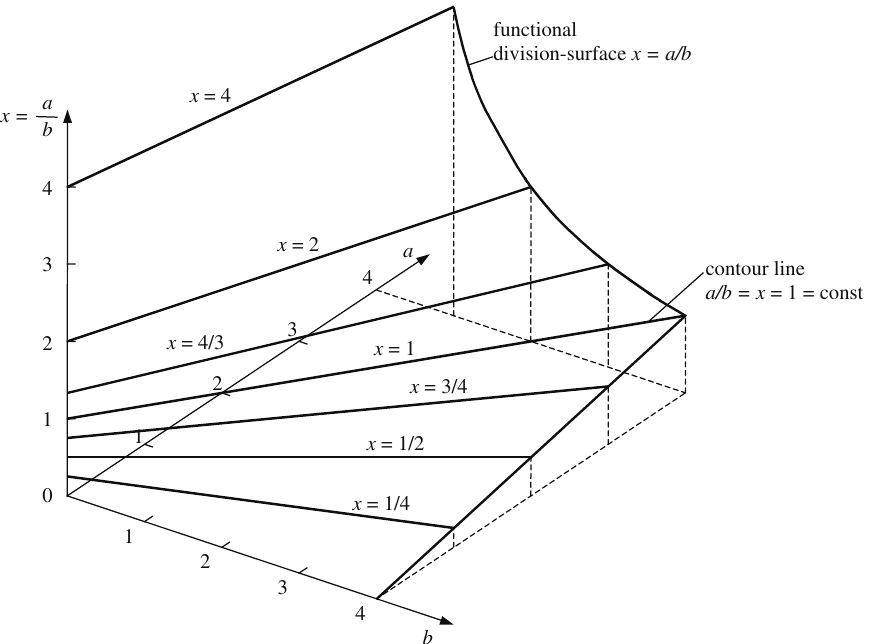
Fig. 3. Functional surface of the division a / b = x for a > 0 and b > 0, where x means a division result.